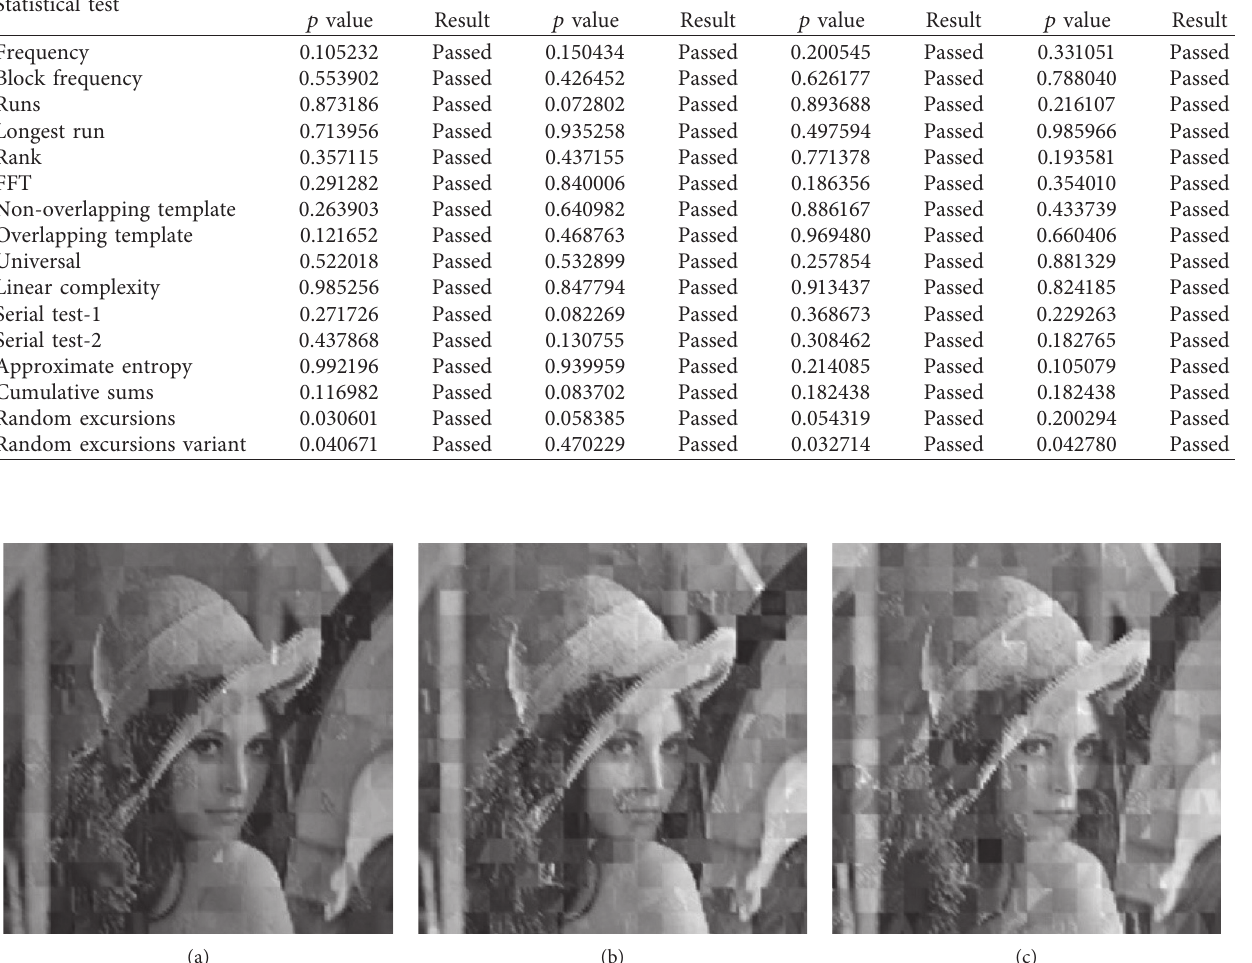
� 0 . 9306. (c) Speckle noise: mean is TG